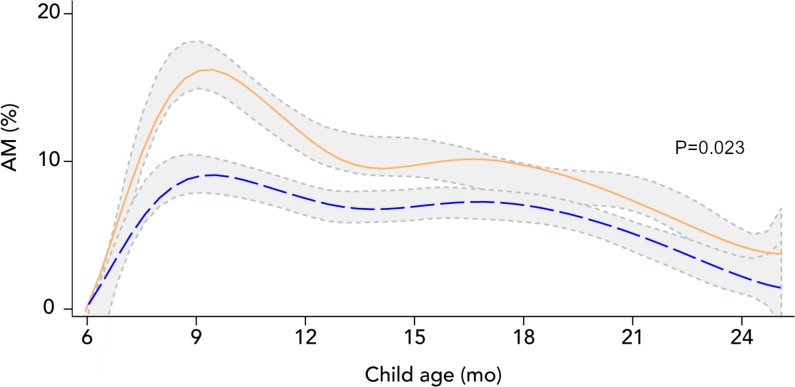
Effect modification of the intervention by child age on AM prevalence during follow-up of children enrolled in the longitudinal study (n = 10,282 child visits in the comparison arm and n = 10,236 in the intervention arm).The blue dashed line represents fitted values obtained from the regression model for the intervention arm. The orange solid line represents fitted values obtained from the same regression model but for the comparison arm. Gray areas represent 95% confidence bands of kernel-weighted local polynomial smoothed values by study arm using the observed data. Mixed-effects regression models with restricted cubic splines (knots at 9, 12, and 16 months of child age) were used with health center catchment area and child as random intercepts and health district, sampling strata, month of inclusion, child sex, whether the child was a first live birth or not, age splines, and intervention as fixed effects. A chunk Wald test was used to test the “age spline × intervention” interaction terms (p-value shown). AM, acute malnutrition.